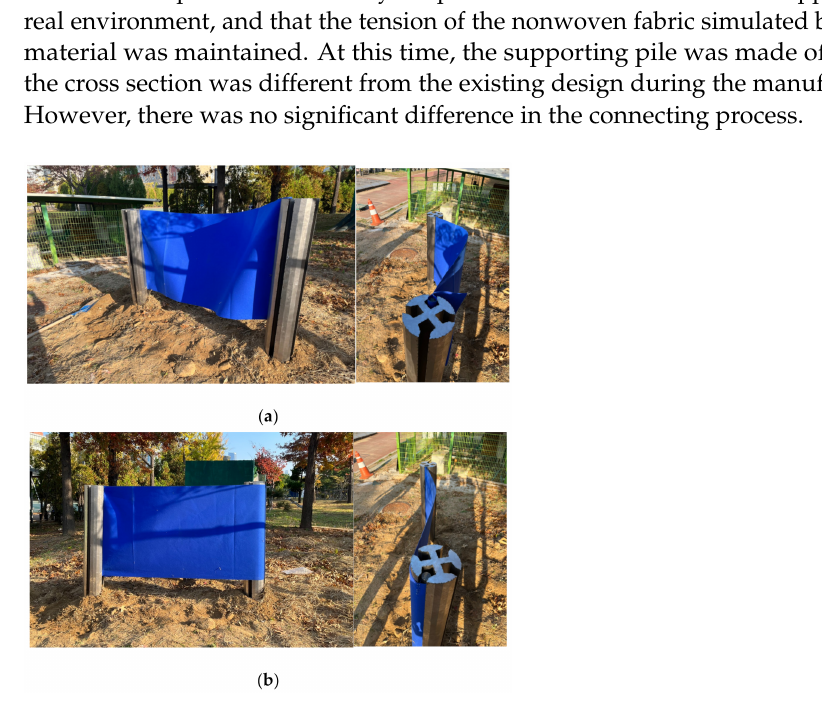
Figure 14. Tension of the nonwoven fabric ( a ) before and ( b ) after the rotation of the supporting pile.